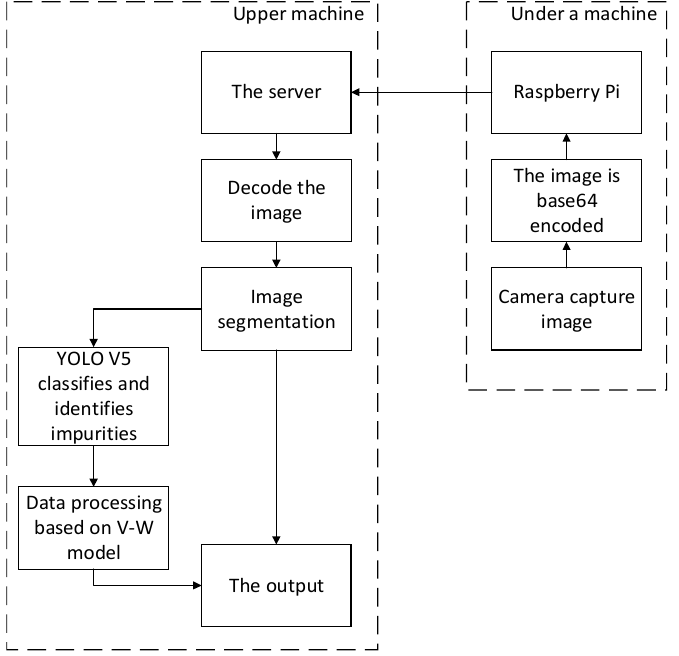
Figure 1. Real-time detection system for machine-picked seed cotton.